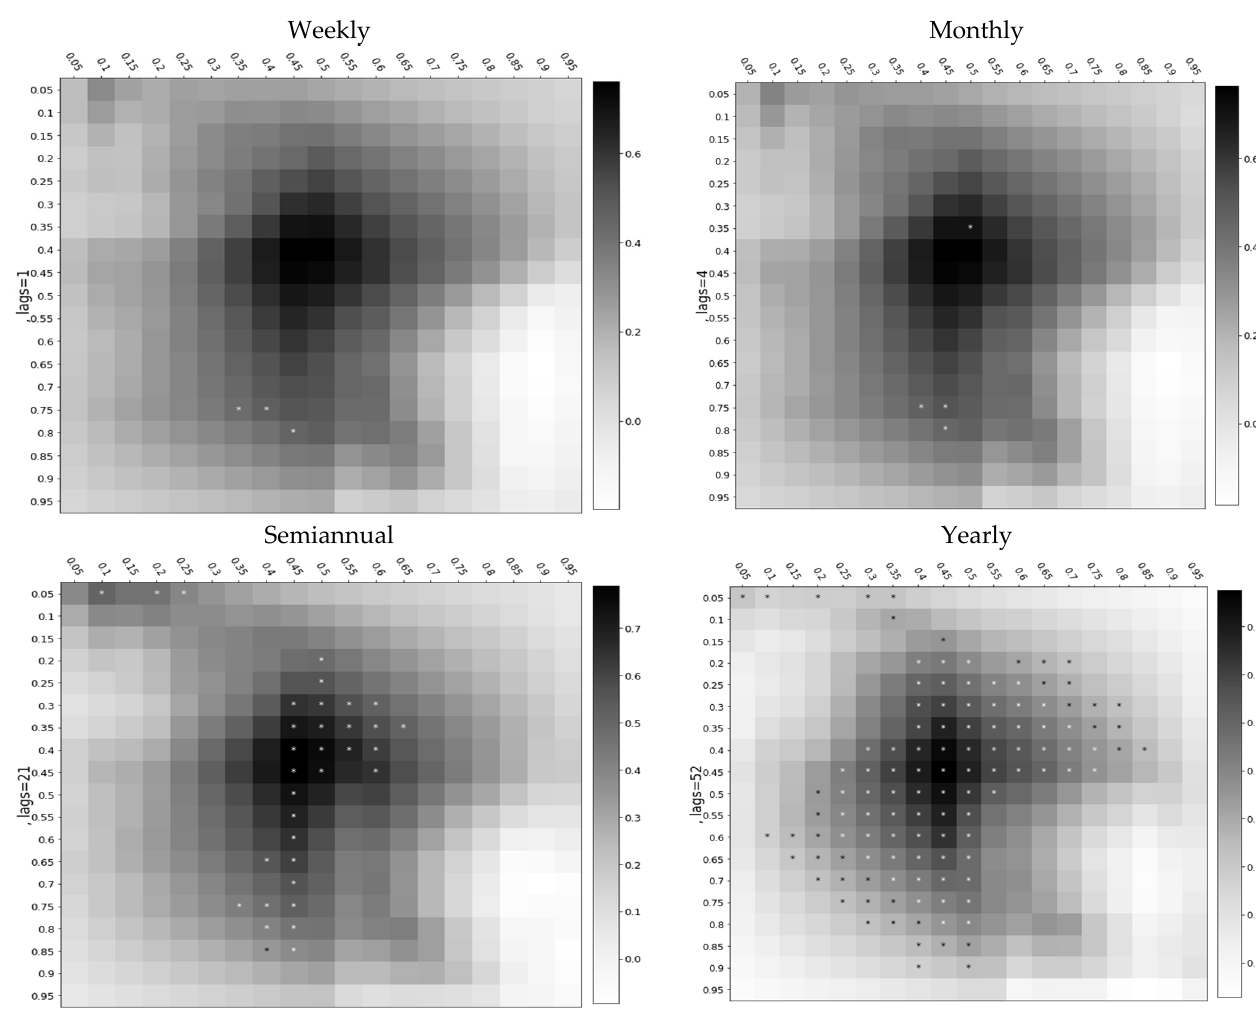
Figure 2. Cross-quantile dependence from oil price to foreign assets. Note: * indicates significance at 10% level.